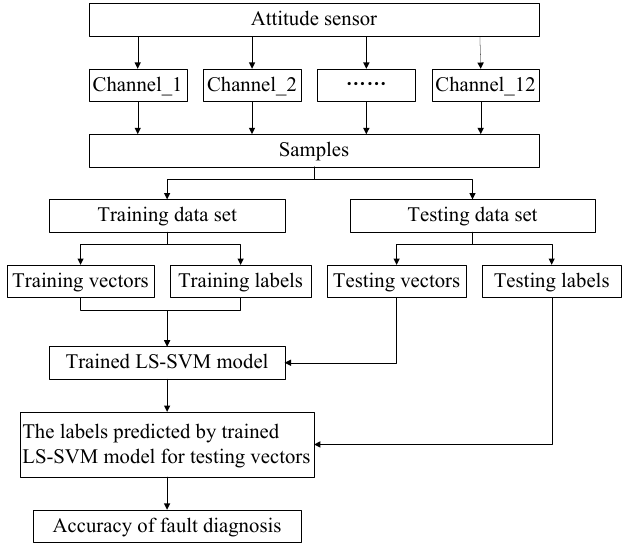
Figure 5. Overview of the proposed approach.